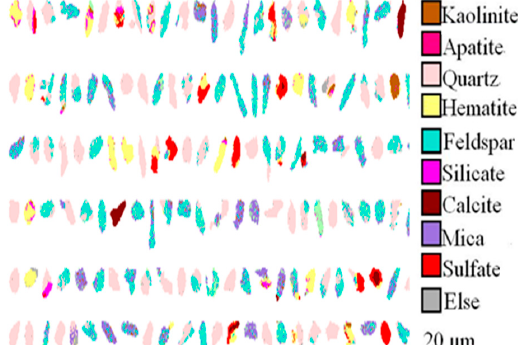
Table 1. Main chemical composition of the stone coal roasted residue (wt %).